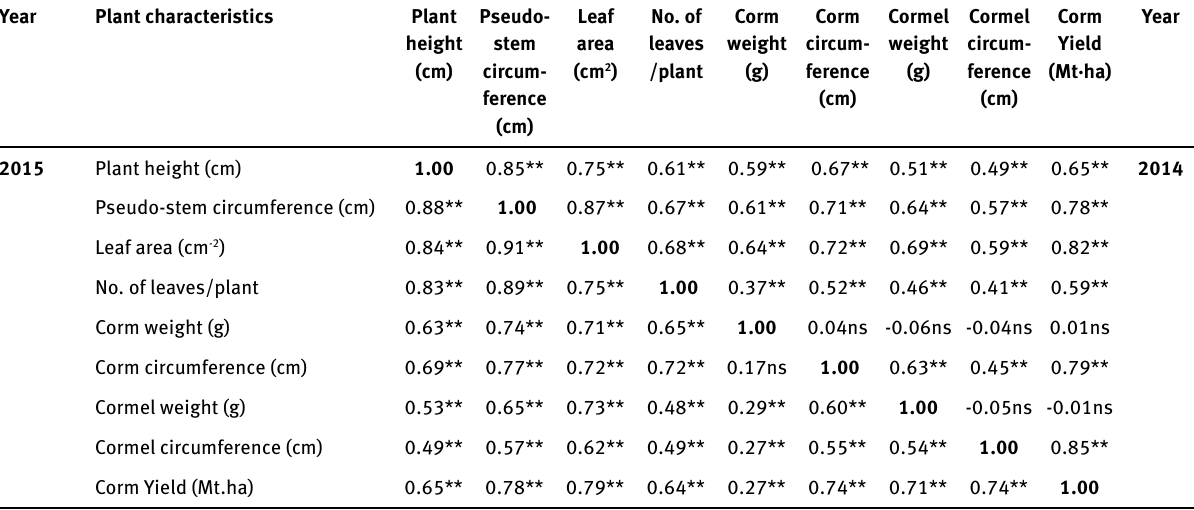
Table 9: Correlation coefficients between different growth and yield attributes of tannia accessions (above diagonal) in 2014 and (below diagonal) 2015 cropping seasons Year Plant